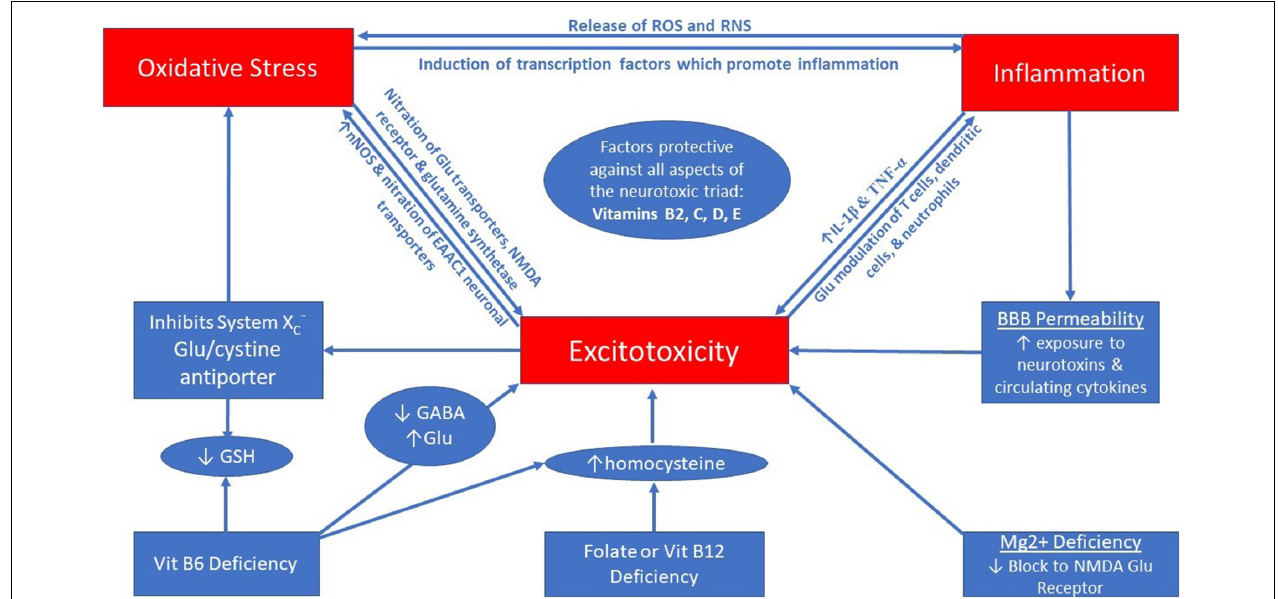
FIGURE 1 | The neurotoxic triad is a self-perpetuating cycle between excitotoxicity, oxidative stress, and